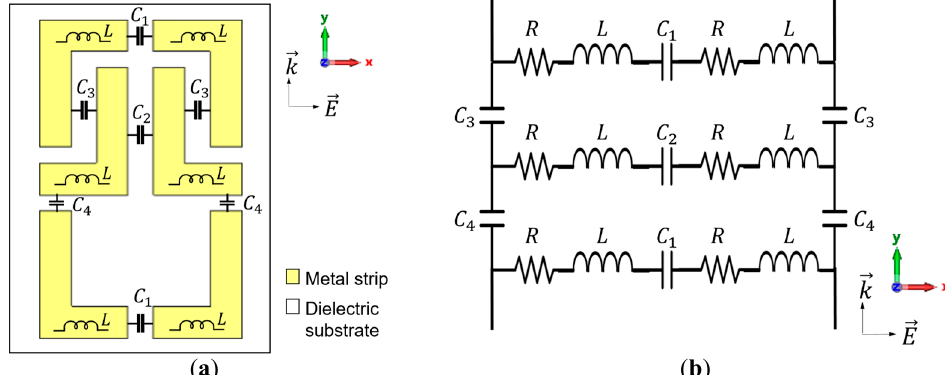
Figure 4. ( a ) Schematic of the designed L-shaped unit cell and ( b ) its equivalent circuit.